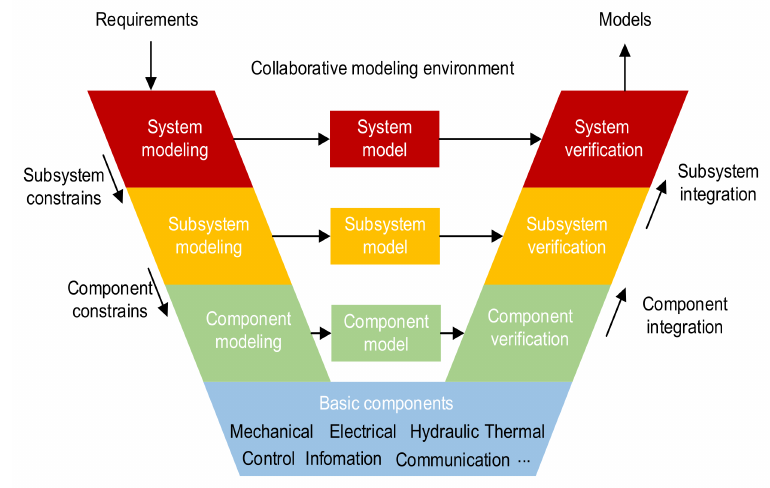
Figure 1. V-shaped process of system